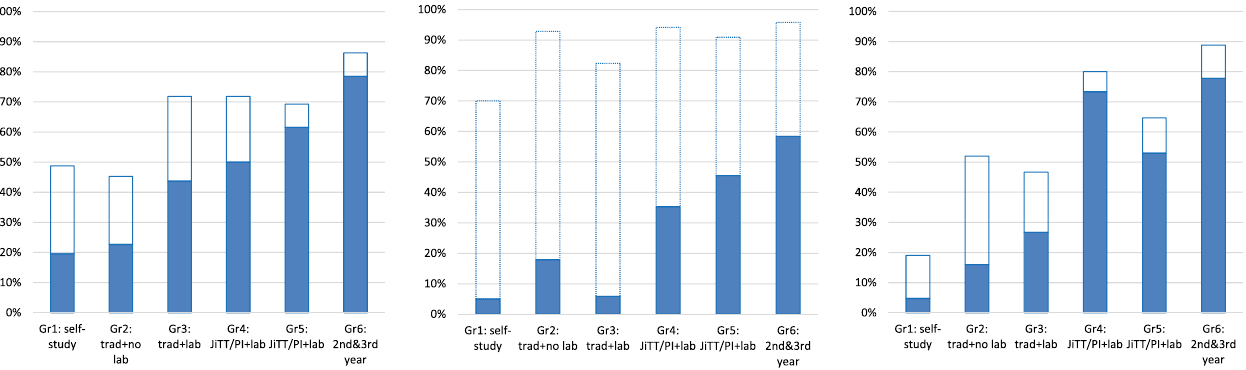
FIG. 2. From left to right: Results of IP, HP, and MP question for each student group (details of the groups see Table I). For IP and MP the empty bars show the percentages of correct answers and the solid bars show the fraction of students giving correct reasoning. For HP the empty bars with dashed frame indicate the percentages of correct answers to the case, when friction is neglected, while the solid bars display percentages of students with correct reasoning stating that friction has no influence on their